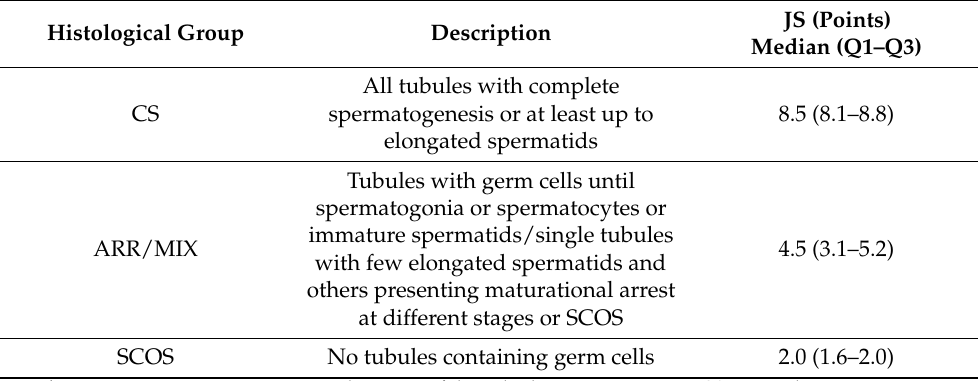
Table 1. Histopathological description and Johnsen score (JS) of testicular biopsies. Histological Group Description All tubules with complete CS spermatogenesis or at least up to